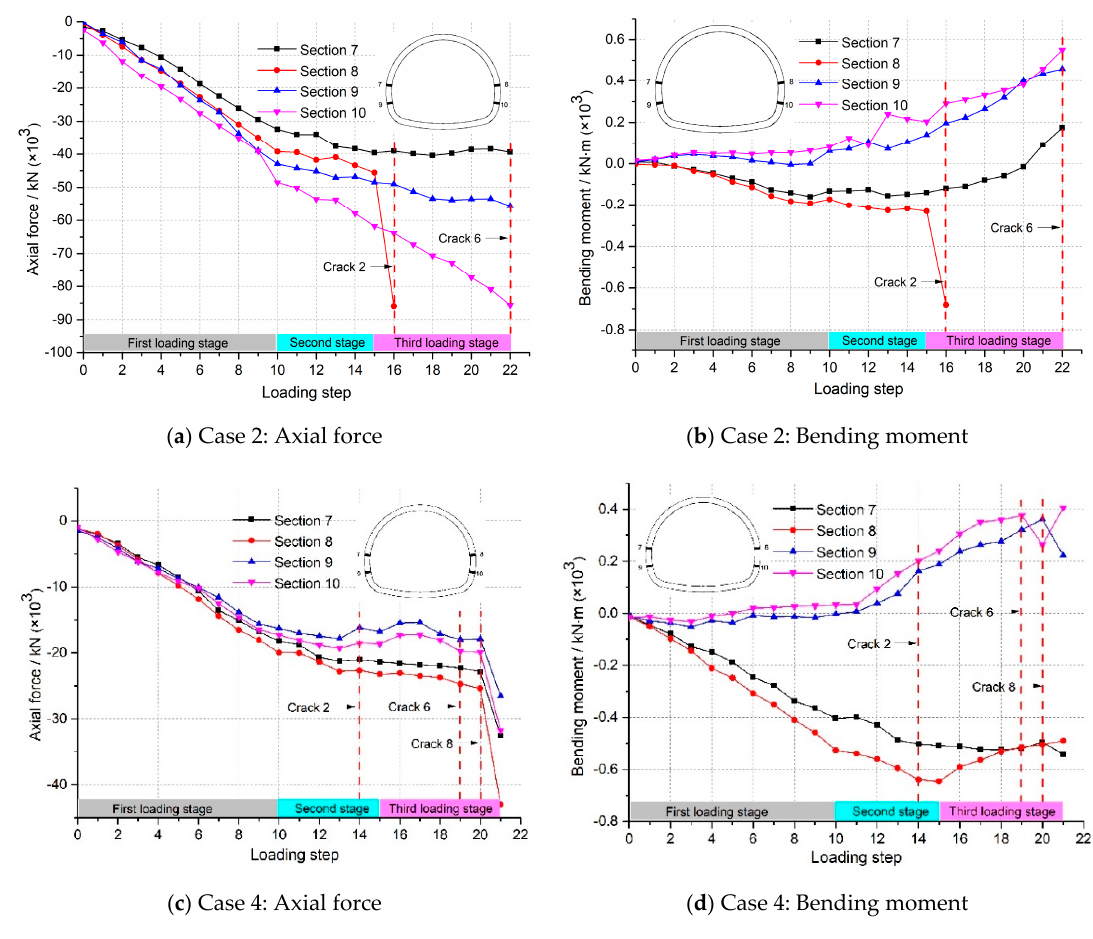
Figure 18. Internal force curves of the sidewall Sections 7–10: ( a ) axial force in case 2, ( b ) bending moment in case 2, ( c ) axial force in case 4, and ( d ) bending moment in case 4.